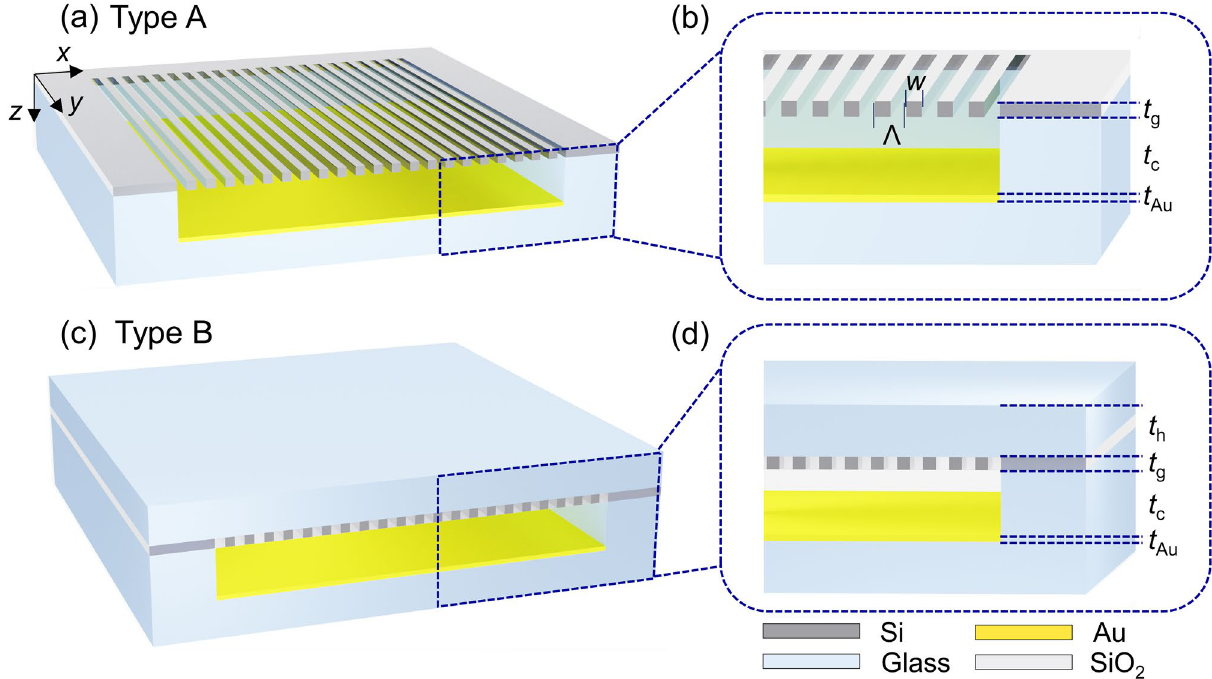
Figure 1. Schematic illustration of an absorption enhanced resonant structure ( a ) with an open-slit top dielectric metasurface and ( c ) with an enclosed dielectric metasurface by a glass handle. The two different resonant structures with their own distinct top dielectric metasurface are (a) for gas sensing and ( c ) for liquid sensing. The zoom-in cross-sectional view of each sensor is shown as ( b ) and ( d ), with the following design parameters: period (Λ), Si grating bar width ( w ), Si grating thickness ( t g ), cavity thickness ( t c ), Au thickness ( t Au ), glass handle thickness ( t h